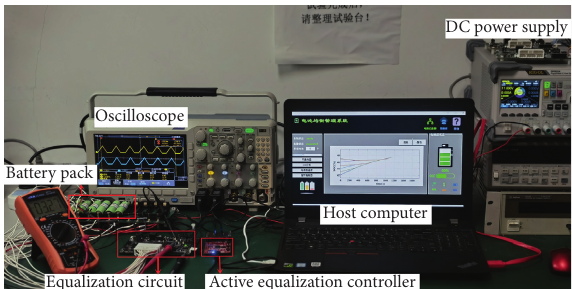
Figure 11: Photograph of the experimental setup and associated instruments.